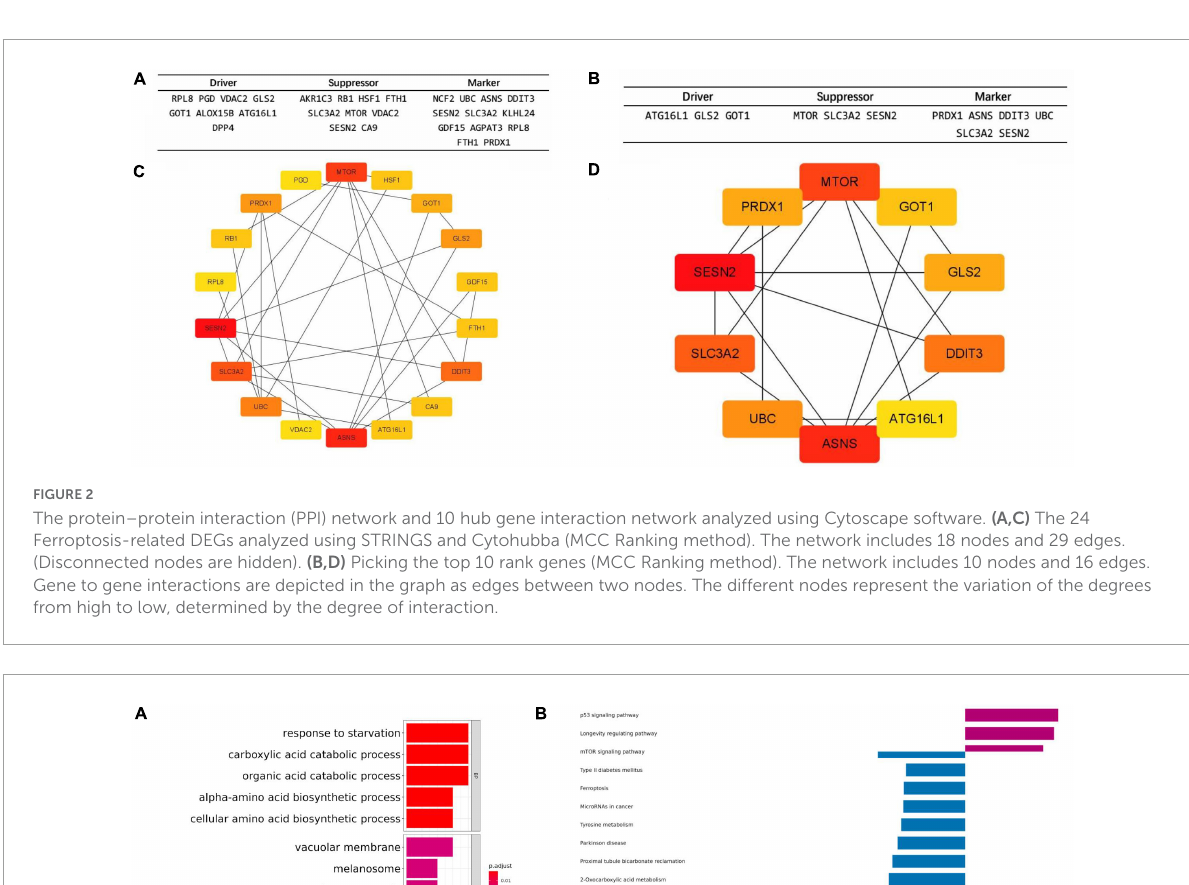
evaluate clinical value for candidate genes. In Figure 5C , the AUC of ASNS and SESN2 was greater than 0.7 in the m1